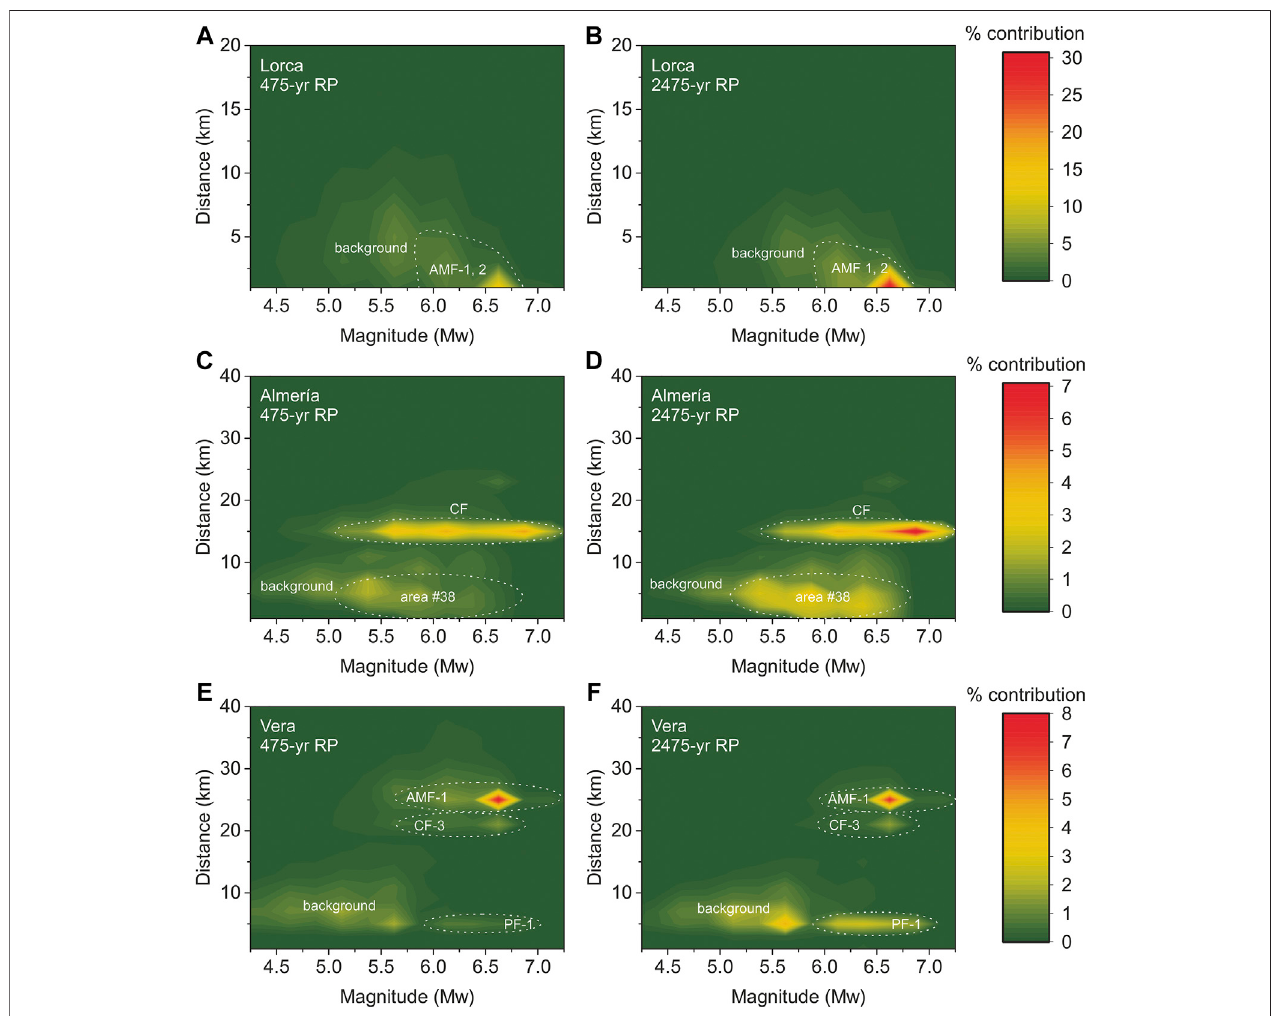
FIGURE7|(A) Hazarddisaggregationforthemagnitude-distancerelationshipoftheFM_bgmodelinthecitiesofLorcaforthereturnperiodsof475 yearsand; (B) 2,475 years; (C) Almería for 475 years and; (D) 2,475 years; ( E) Vera for 475 years and; ( F) 2,475 years. A common color scale is set for the two return periods representing each city. The main sources contributing to the hazard of each city and return period are highlighted. For disaggregation fi gures of all the cities in Figure 6 and for the four return periods of 475, 975, 2,475, and 4,975 years, see the Supplementary Material of this paper.